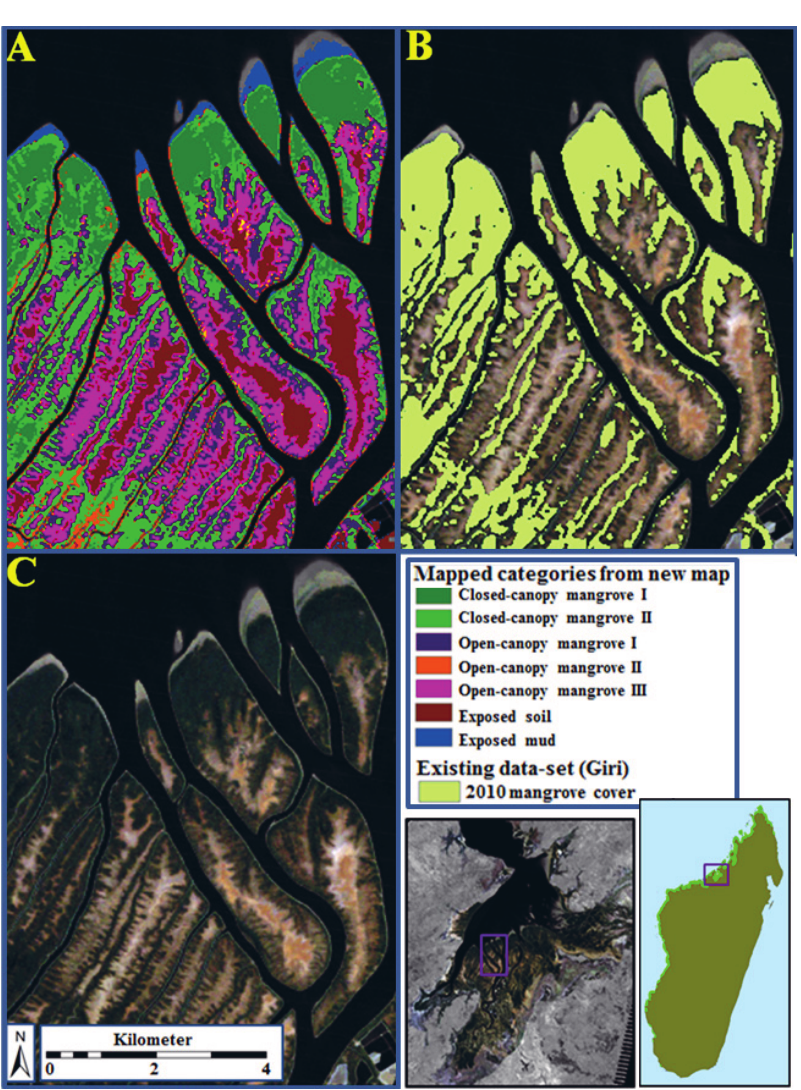
Figure 7. Classification results (panel A ) compared with national-level USGS mangrove data [58] (panel B ). A true color composite of Landsat bands 1, 2, and 3 is shown for context (panel C ) and as the background image (panels A , B ). The under-representation of lower-stature, comparatively sparse mangroves and surrounding land-cover categories in the USGS data-set is shown in panel